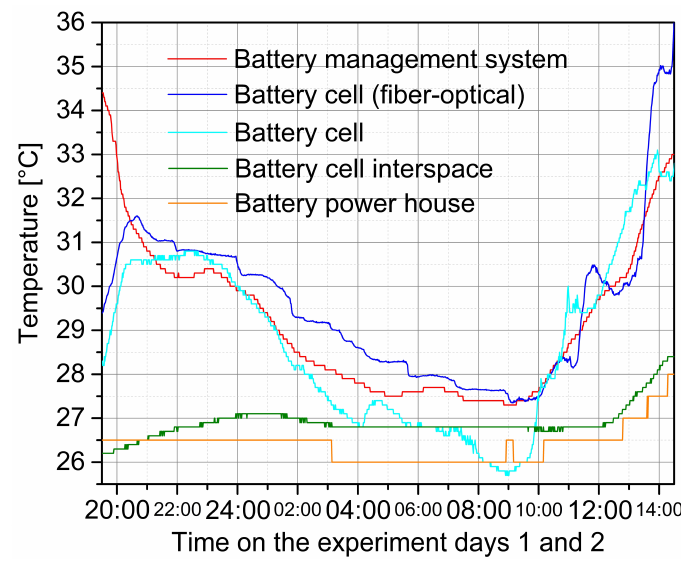
Figure 4. Characteristic temperature courses during the charge and discharge experiment. In addition to the temperature variation of the master battery management system, the values of an interspace of two centrally located cells within the first string are plotted. Furthermore, the temperature of the current collector of one of the last-mentioned cells is shown from the conventional resistant-electrical as well as fiber-optical measurement, whose setup is illustrated in Figure 1. For comparison, the temperature inside the battery powerhouse is additionally plotted. Due to the lower impact on safety and status analysis, this value is recorded with a lower resolution of 0.5